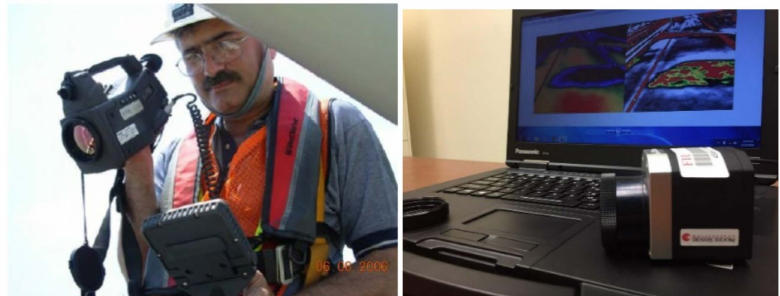
Figure 17. Infrared camera used for IT method [44].